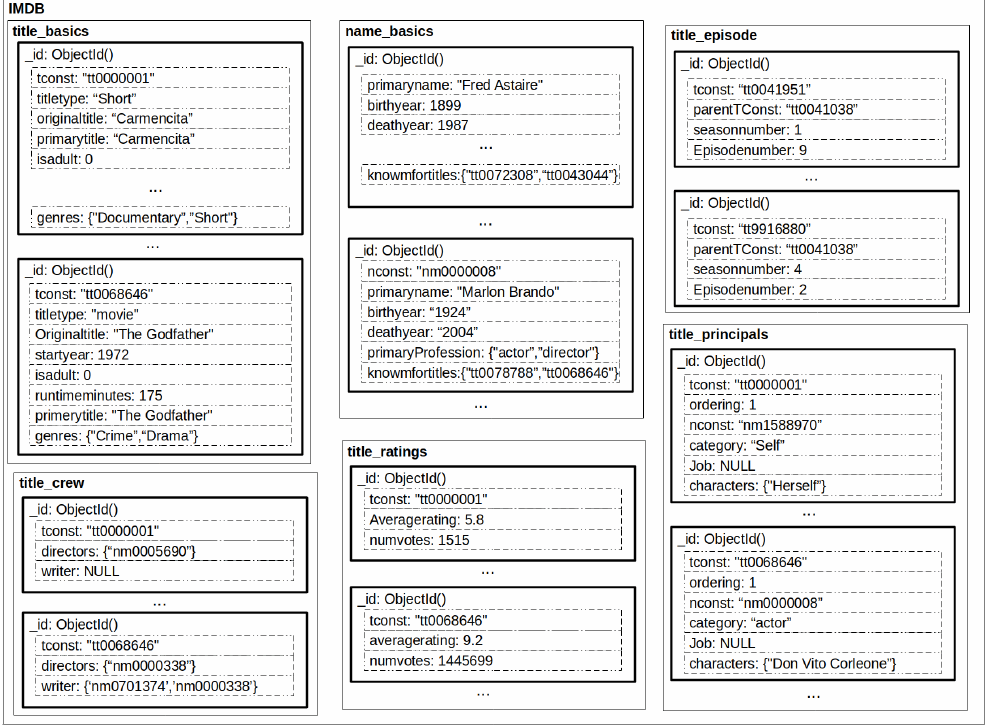
Figure 6. IMDb mapped to